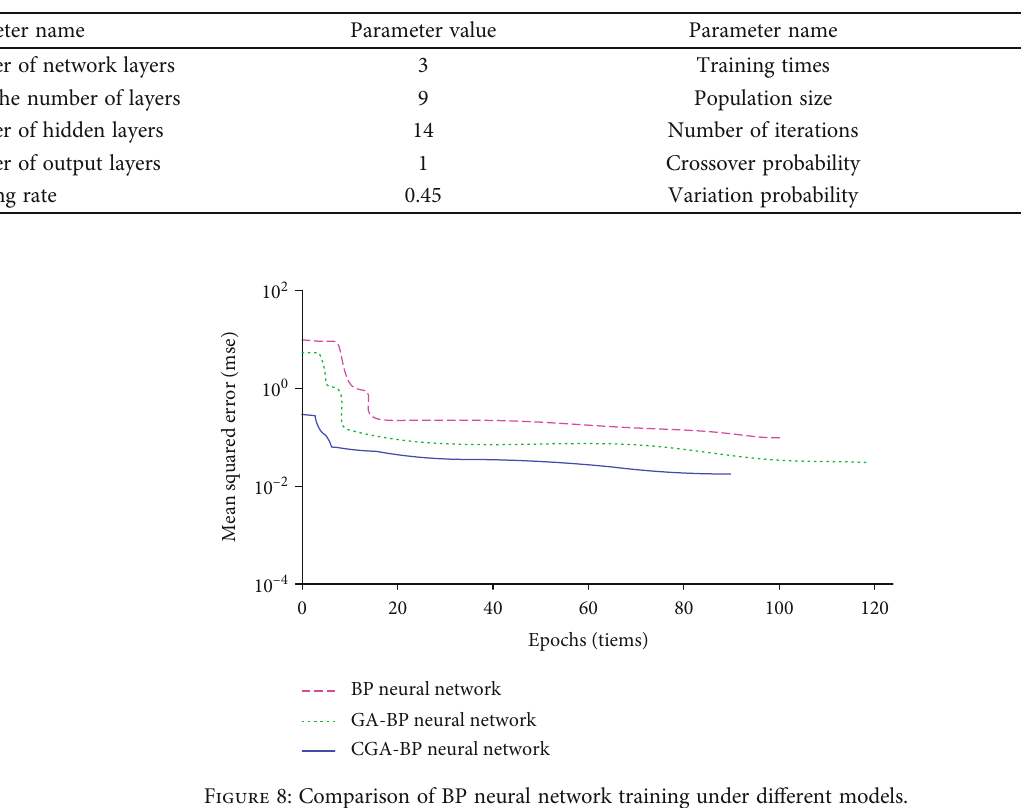
Table 3: Parameters of neural network.